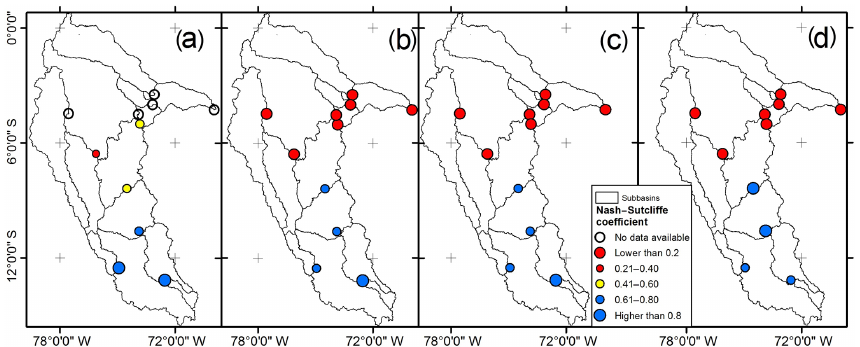
Figure 4. Nash–Sutcliffe efficiency coefficients map for simulations using (a) observed Rainfall (PLU), (b) GPM-IMERG, (c) TMPA V7 and (d) TMPA RT rainfall data.